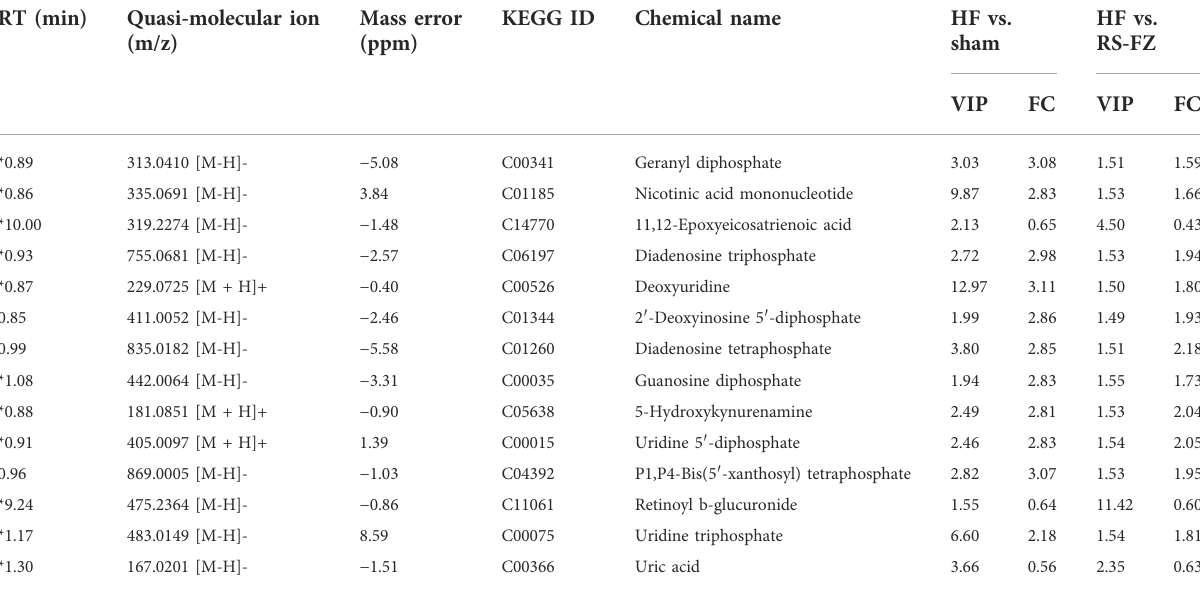
TABLE 1 Metabolites identi fi ed as potential biomarkers. RT